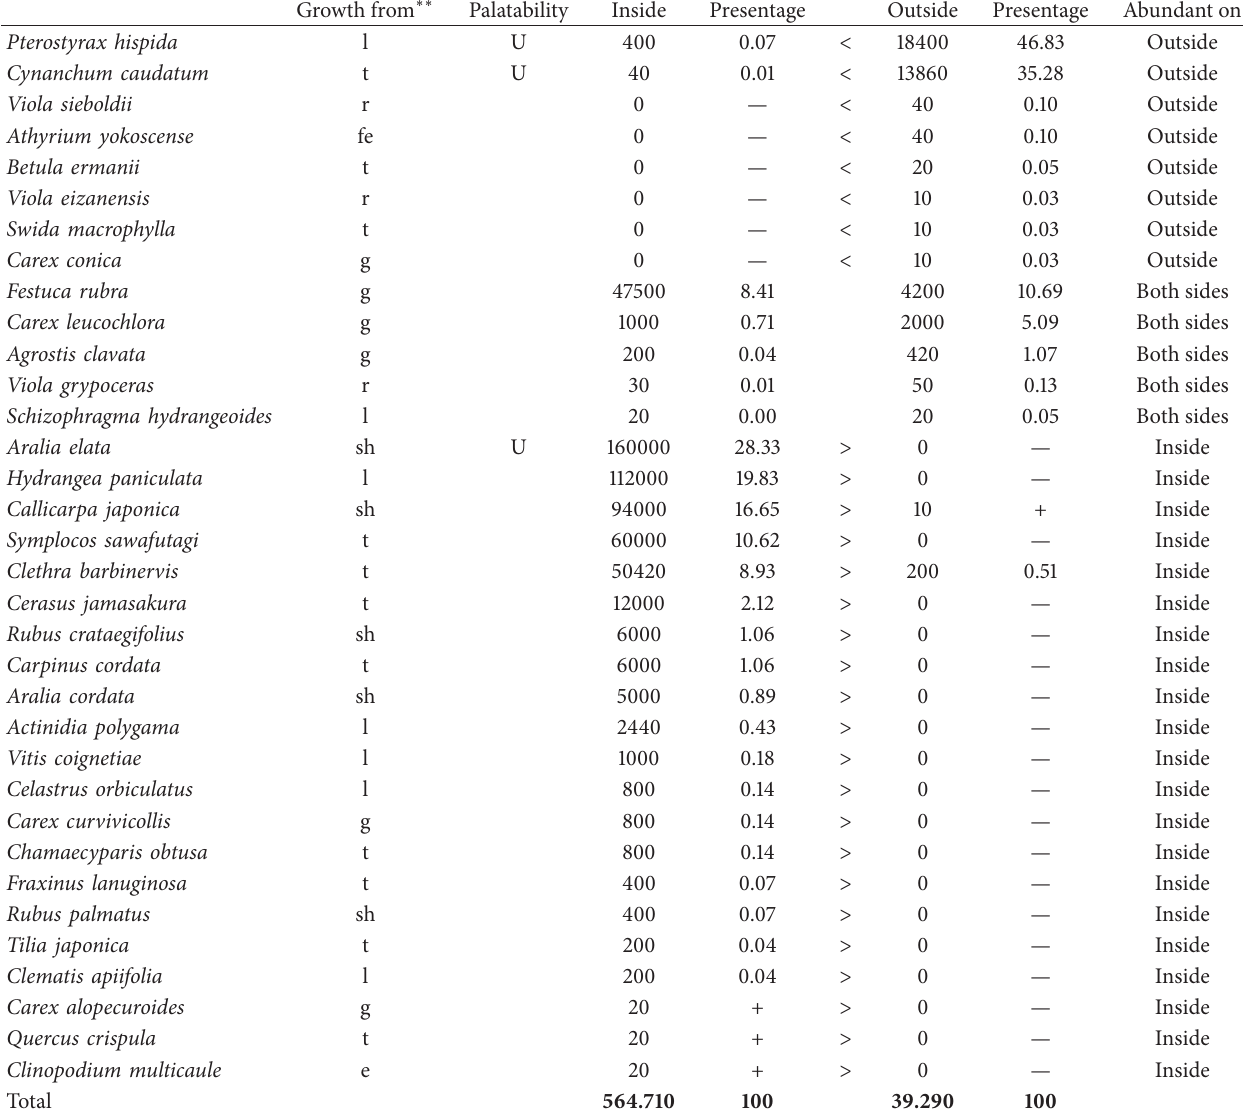
Table 3: Mean values of biomass indices ∗ of undergrowth plants appearing in five 2 m × 2 m plots inside and outside the deer exclosure at Okutama, western